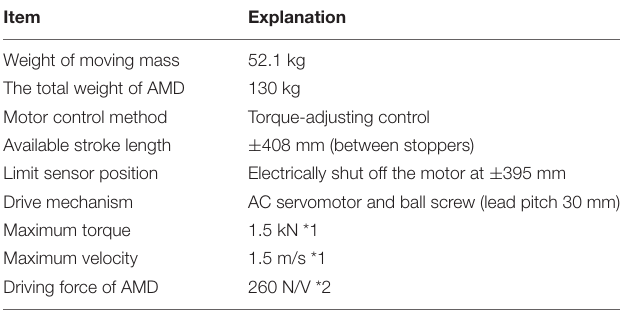
TABLE 1 | Mechanical specification of the test device of AMD. TABLE 2 | Material properties of rebar and cylinder test results of concrete used in the RC column specimen.